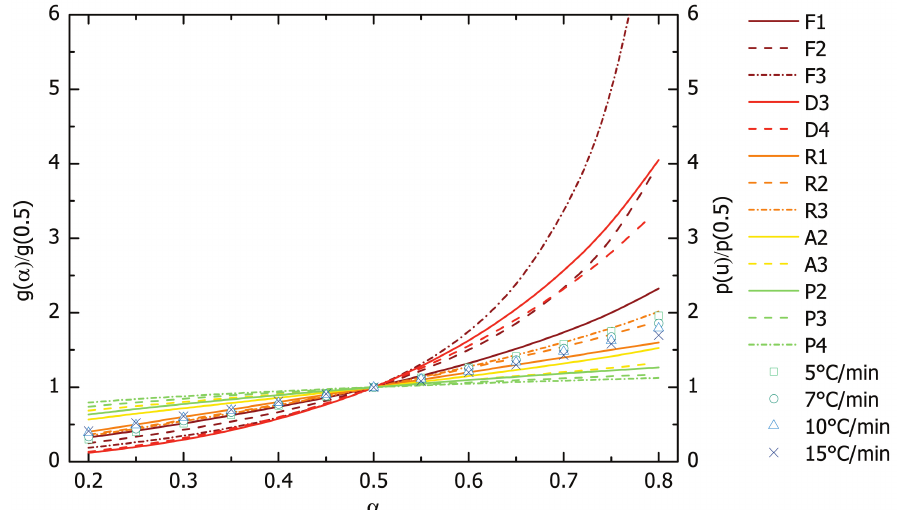
Figure 4. Master plots of theoretical g ( α ) / g ( 0.5 ) and experimental p ( u ) / p ( 0.5 ) against α for the thermal decomposition of the animal